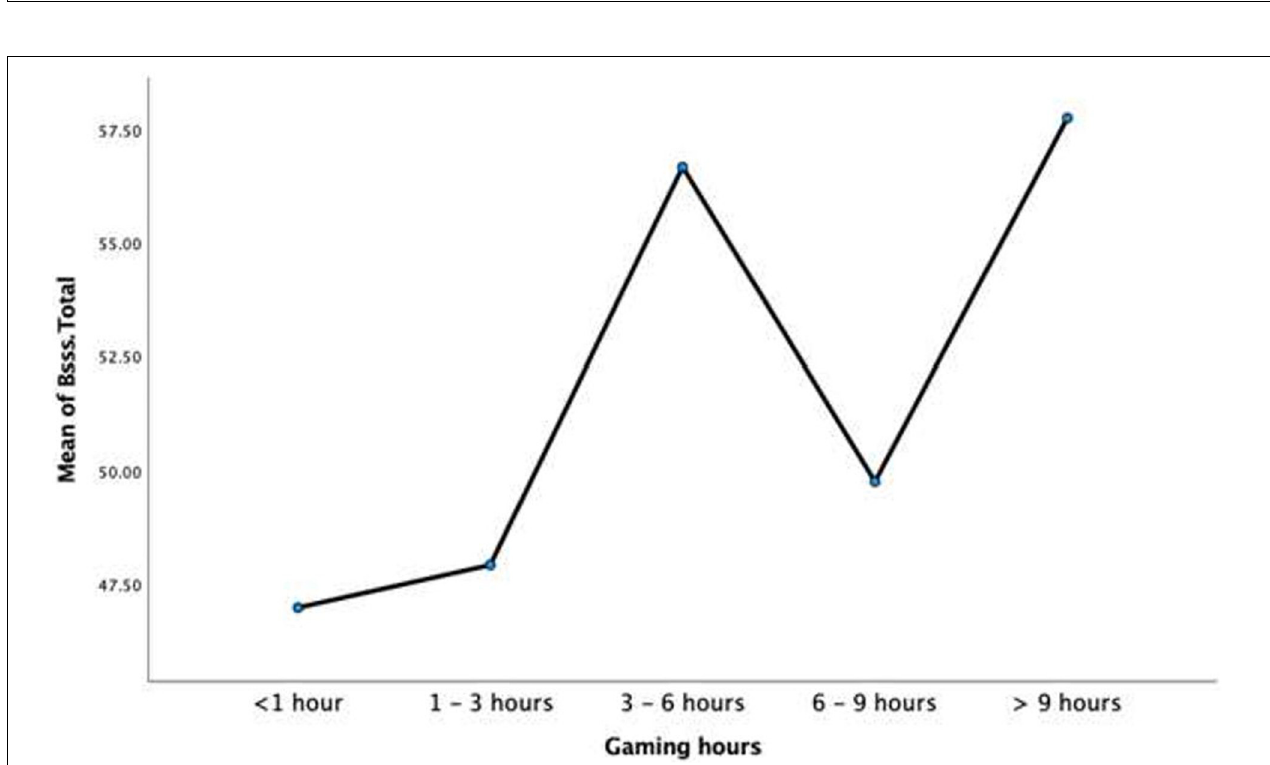
FIGURE 6 | Mean brief sensation seeking scale (B-SSS) scores as a function of gaming hours.